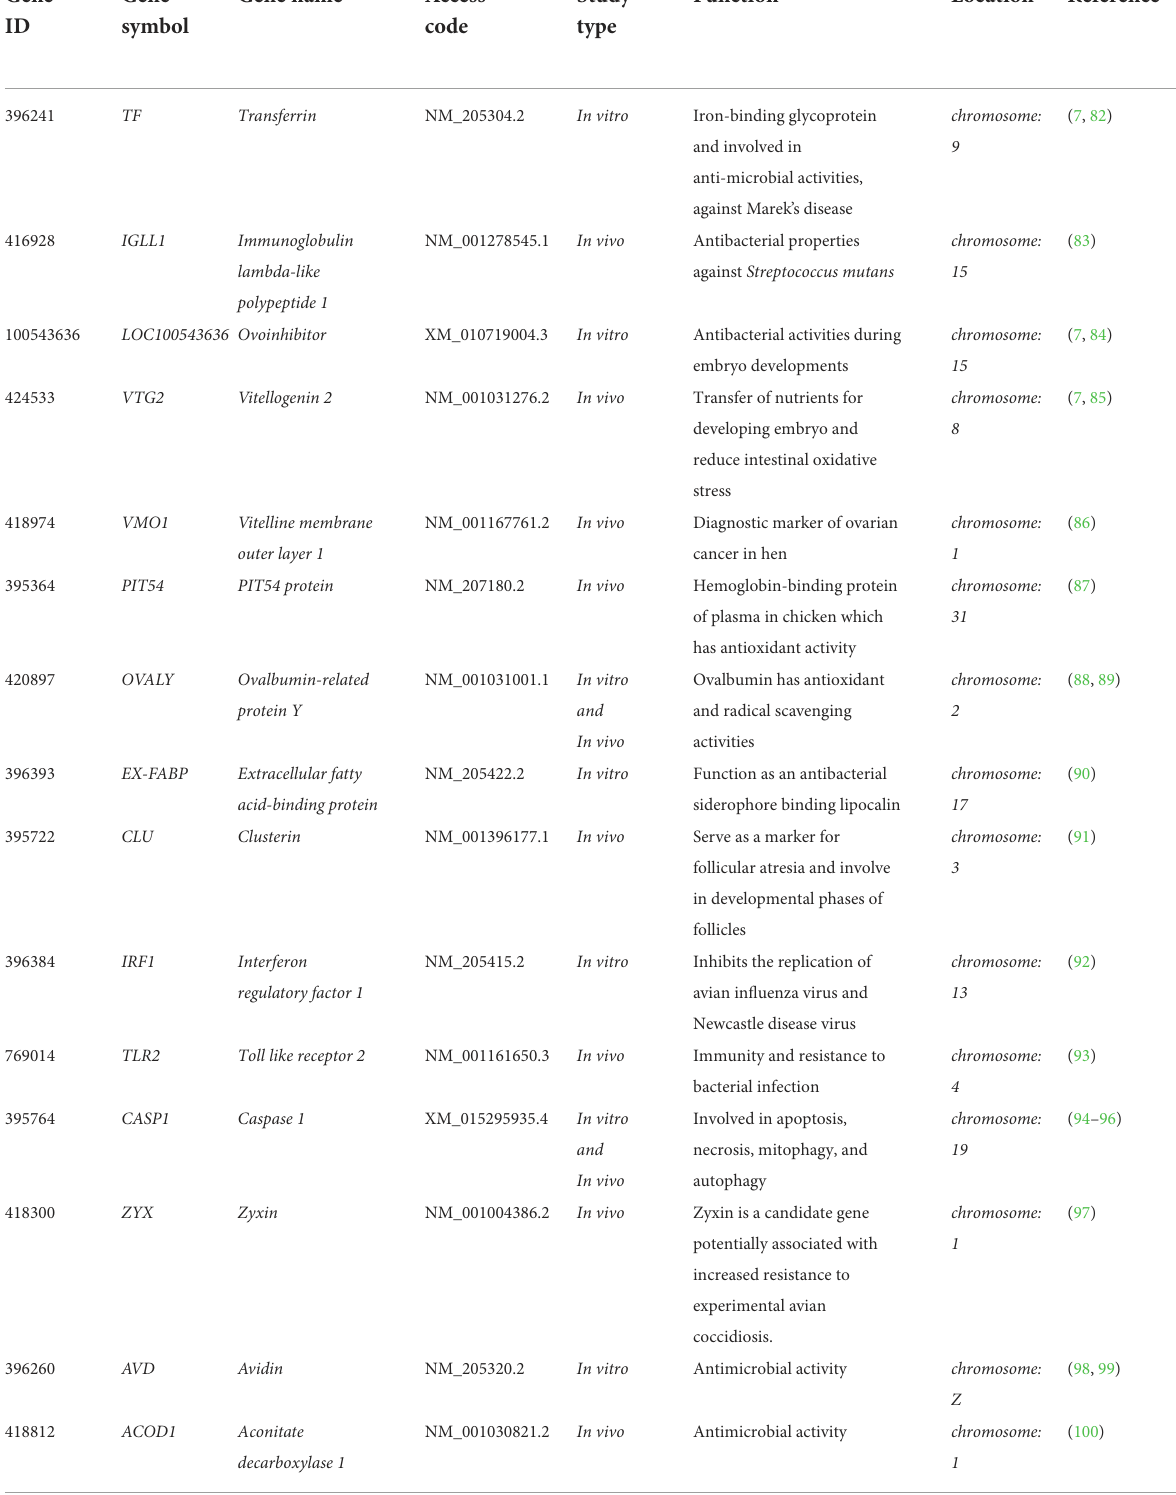
TABLE 1 The key genes are involved in the infectious diseases of